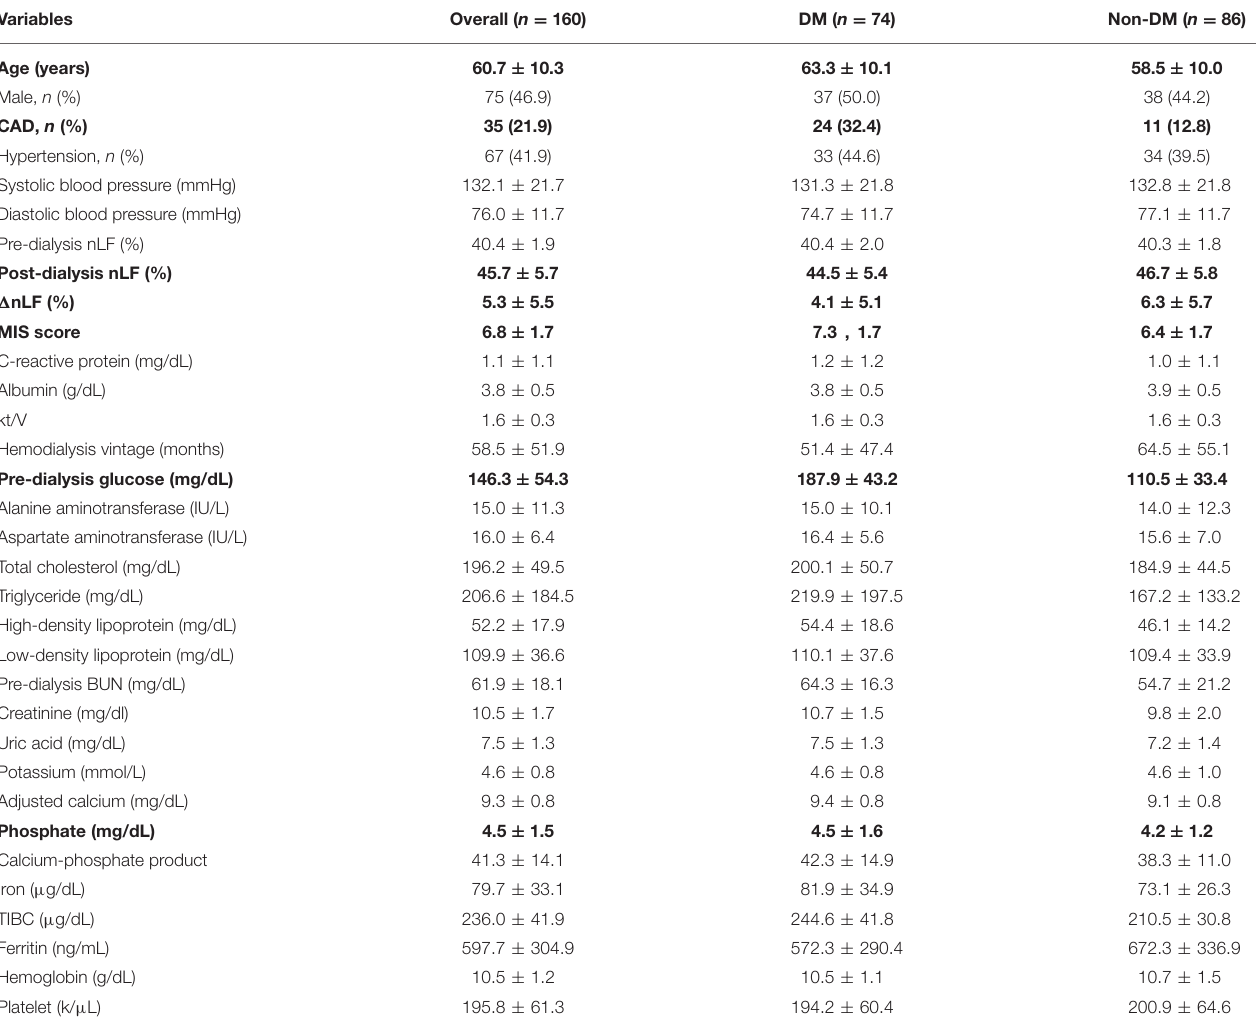
TABLE 1 | Bio-clinical data of the whole study population with comparisons between DM and non-DM groups.